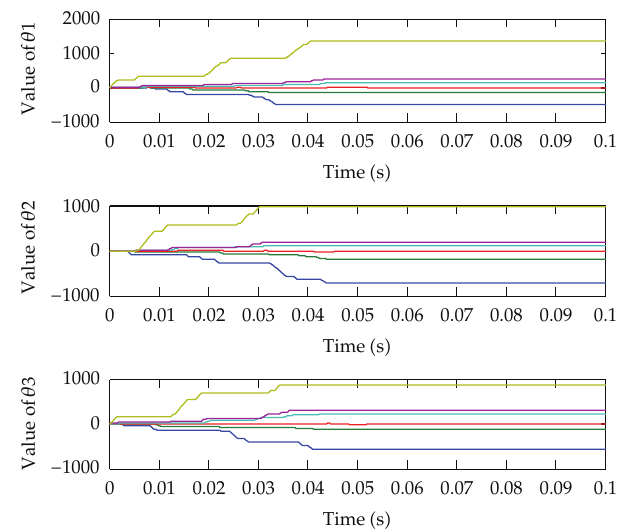
Figure 7: Adaptive values θ 1, θ 2, and θ 3 of adaptive fuzzy